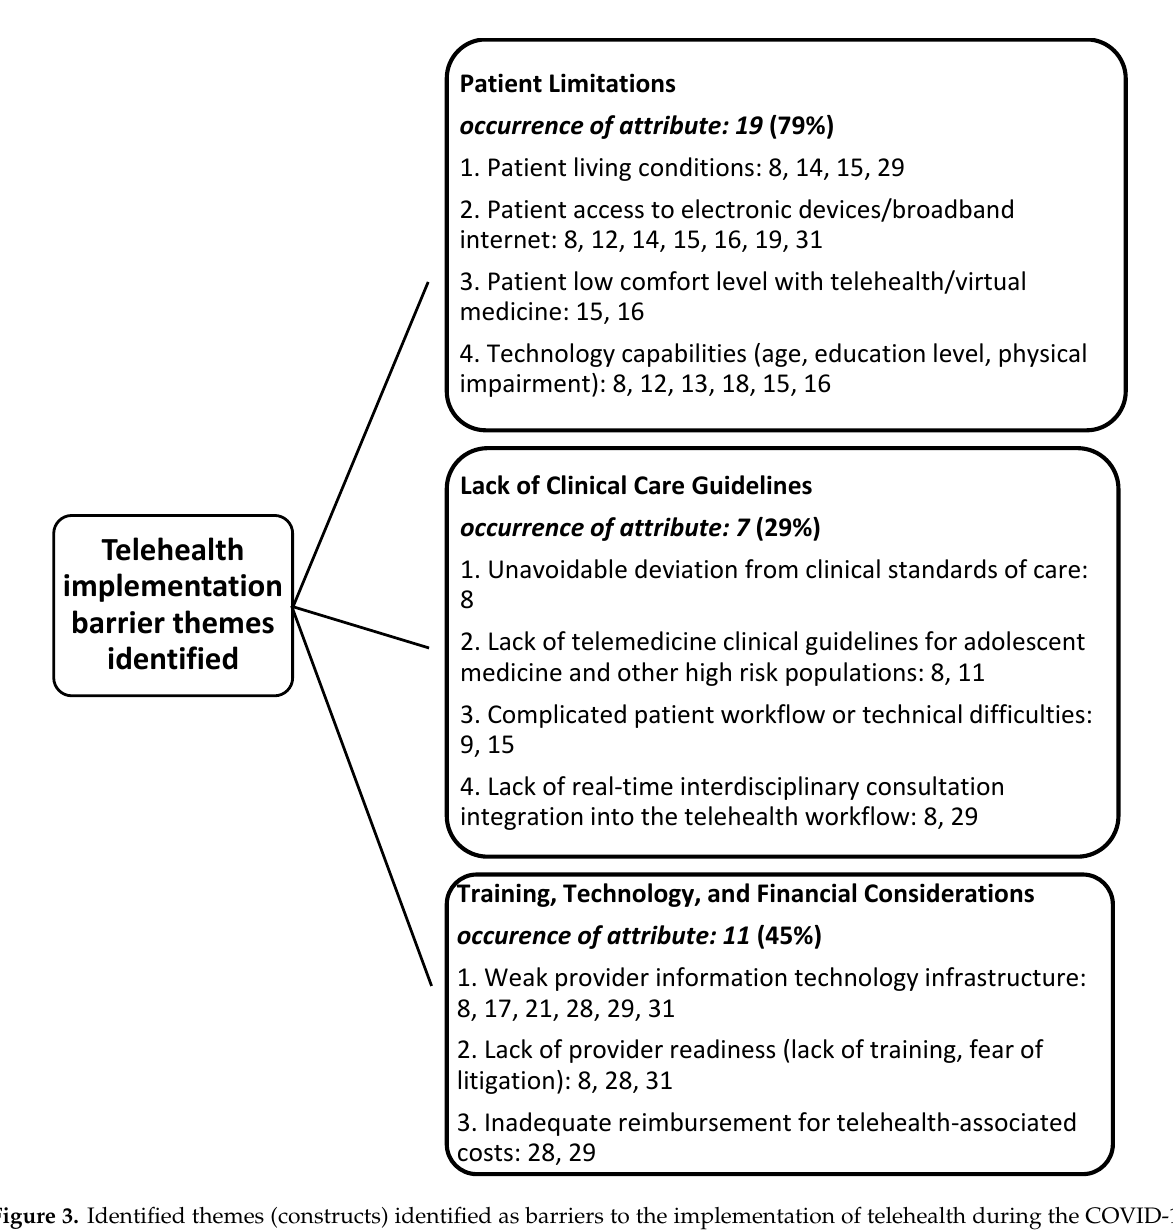
Figure 3. Identified themes (constructs) identified as barriers to the implementation of telehealth during the COVID-19 pandemic in the United States.